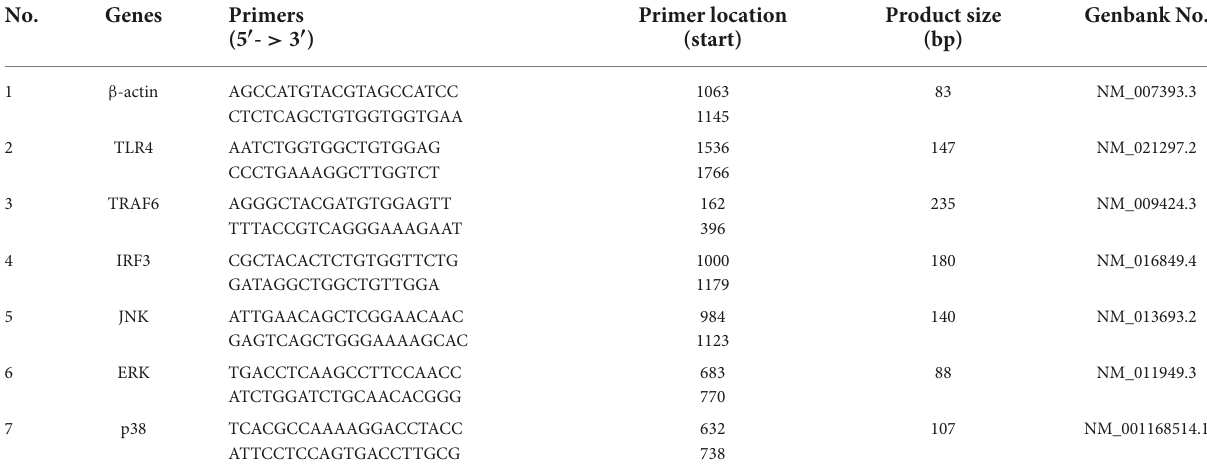
TABLE 1 Primers used for qPCR.